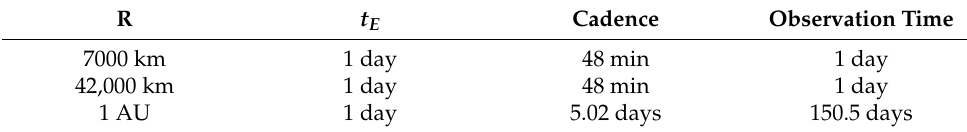
Table 3. Simulation setup